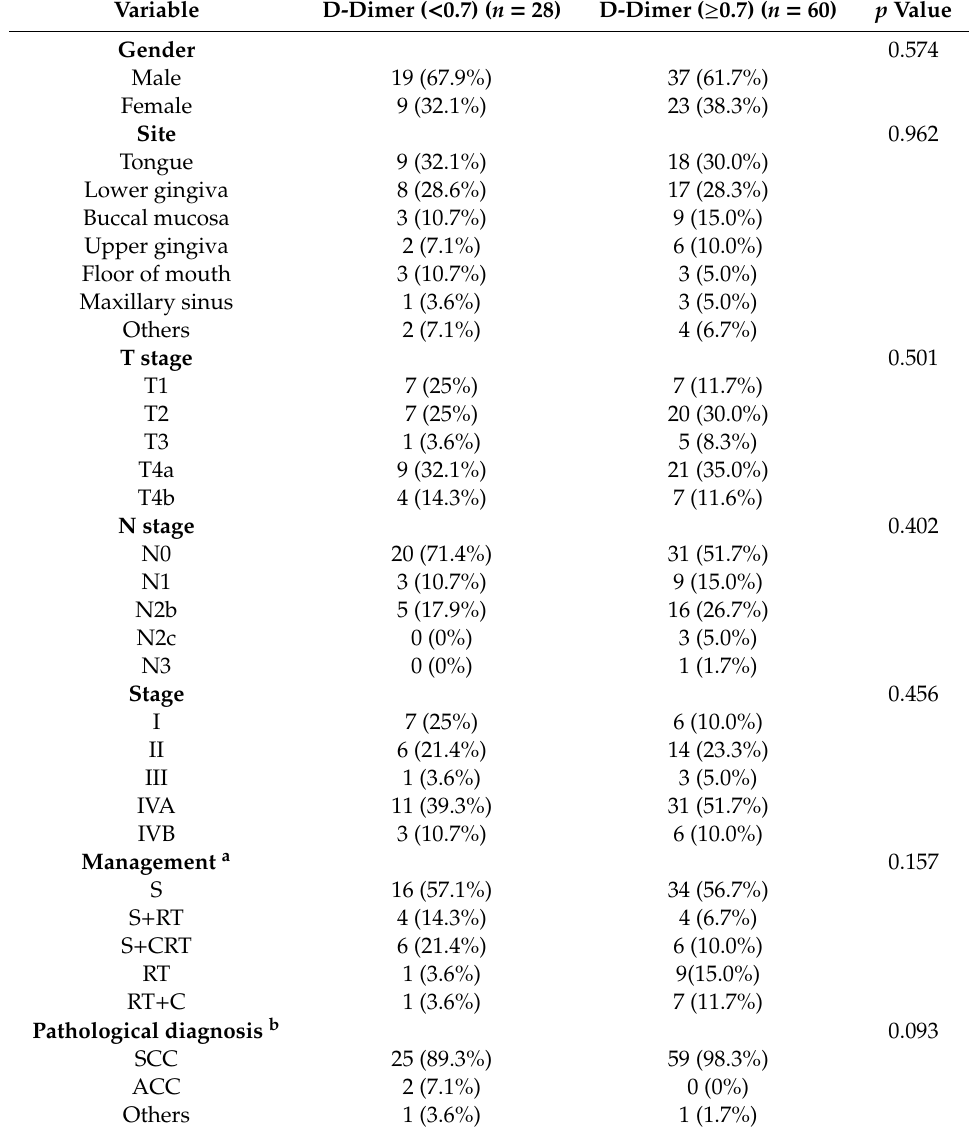
Table 1. Study variables versus